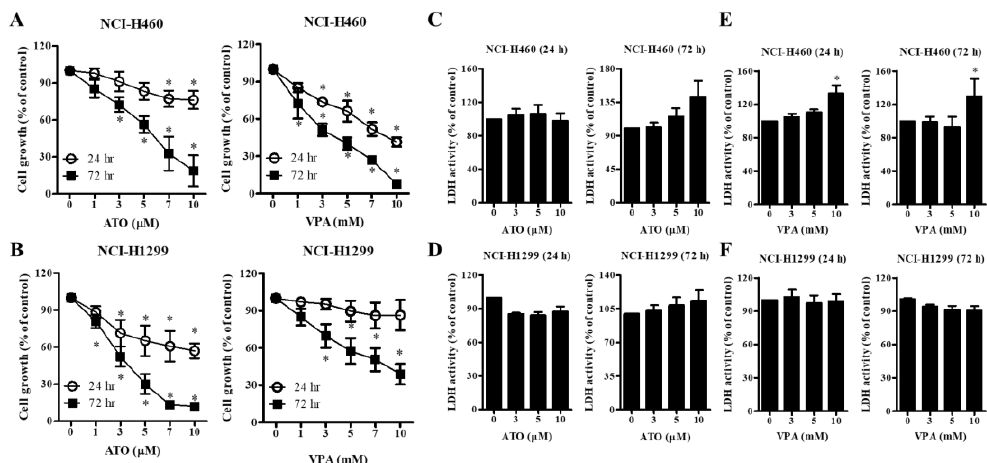
Figure 1. Effects of arsenic trioxide (ATO) and valproic acid (VPA) on cell growth and necrotic cell death in NCI-H460 and NCI-H1299 cells. Exponentially growing cells were treated with the indicated doses of ATO or VPA for the indicated times. A and B : Cellular growth changes in NCI-H460 and NCI-H1299 cells as assessed by MTT assays. C , D , E , and F : Necrotic cell death changes as assessed by LDH release and its activity. Lactate dehydrogenase (LDH) activity changes in ATO-treated NCI-H460 cells ( C ) and NCI-H1299 cells ( D ). E and F : LDH activity changes in VPA-treated NCI-H460 cells ( E ) and NCI-H1299 cells ( F ). * p < 0.05 as compared with the control group. ( n = 3).